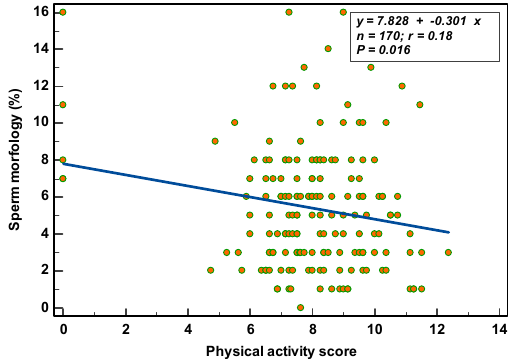
Figure 4. Effects of physical activity on sperm morphology.